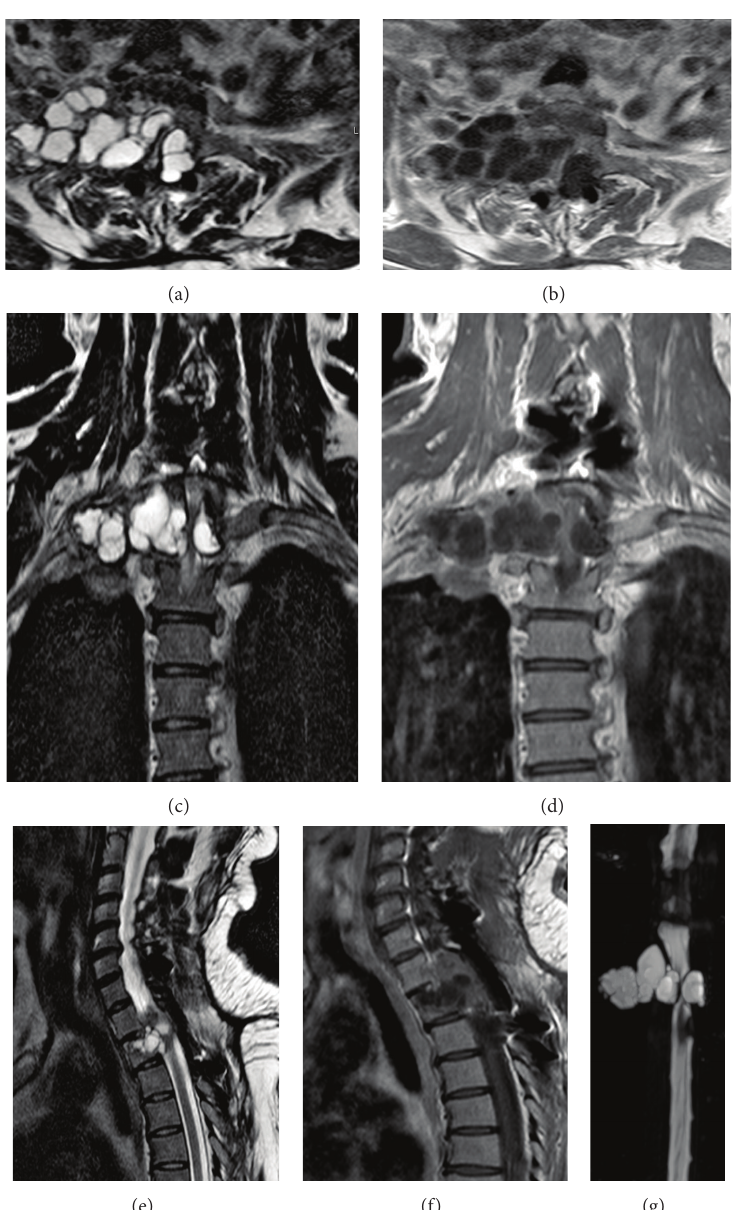
Figure 6: T2 images (a), (c), and (e), T1 images after intravenous gadolinium injection (b), (d), and (f), and MR myelography (g) reveal the presence of a cystic tissue in the chest on the right and severe spinal cord compression due to the presence of multiple hydatid cysts involving the body of D2 and minimally the body of